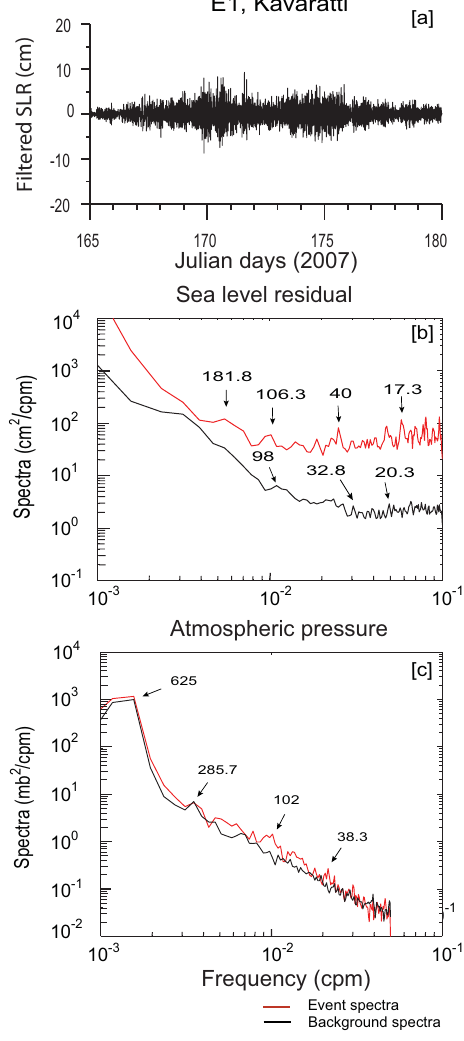
Fig. 4. Characteristics of sea-level residual (SLR) and atmospheric pressure at Kavaratti Island lagoon region during event E1 (a) time series of high pass filtered SLR (period < 2h), (b) spectrum of SLR over 8 days (Julian days 169–176; N = 2304) along with back- ground spectrum (black) and (c) spectrum of atmospheric pressure anomaly over 8 days (Julian days 169–176; N = 1152) along with background spectrum (black). The number associated with signifi- cant peaks is time period in